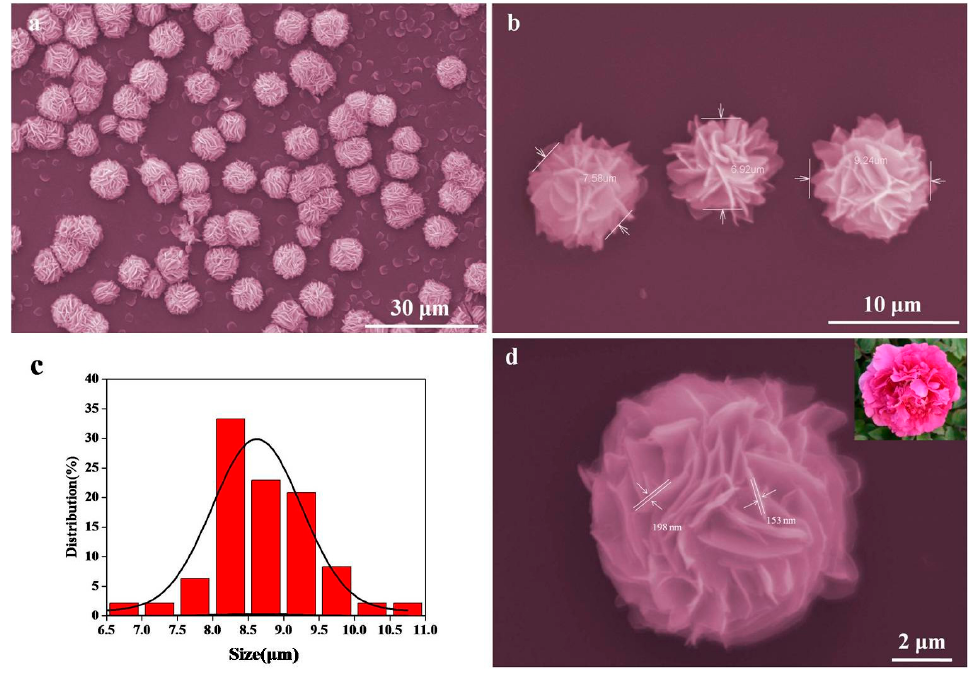
Figure 3. SEM images ( a , b , d ) and diameter distribution ( c ) of Co/BDC CP microparticles fabricated